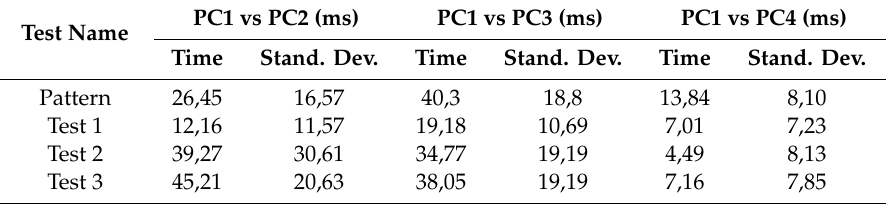
Table 3. Synchronization time of di ff erent tests (Maximum and Minimum time in